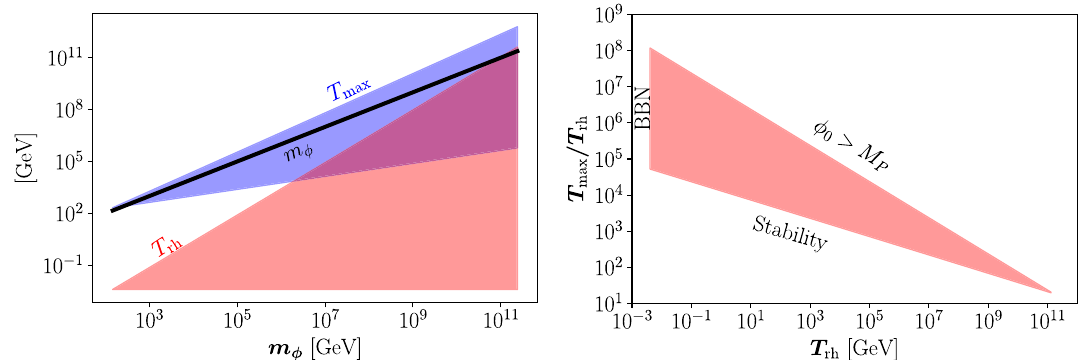
Fig. 2 Left panel: Allowed ranges for T rh and T max as a function of the inflaton mass m φ . Right panel: Allowed range for the ratio T max / T rh as a function of T